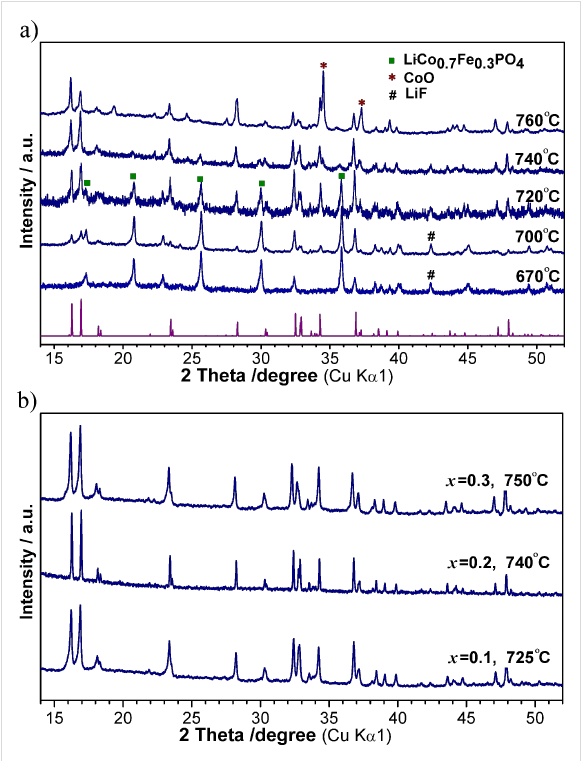
Figure 5: a) XRD patterns of a mixture of LiCo 0.7 Fe 0.3 PO 4 and LiF, annealed at different temperatures, starting from 670 ° С . XRD peaks that correspond to impurities are marked. b) XRD patterns of Li 2 Co 1 − x Fe x PO 4 F ( x = 0.1, 0.2, 0.3), synthesized at the denoted